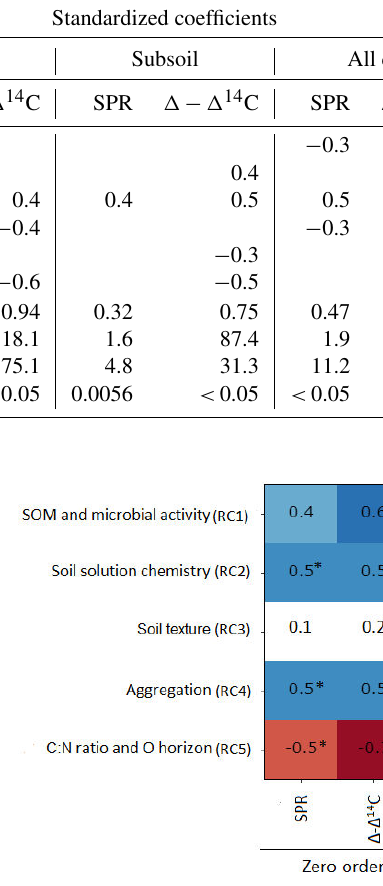
Table 3. Results of three regression models (topsoil only, subsoil only and all data) using RC scores to predict SPR and (cid:49) − (cid:49) 14 C, including standardized coefficients and model performance indicators. For models using all data, soil depth was included as an additional explanatory variable. Blank cells indicate non-significant predictors ( p value < 0.1) that were not selected by the model. Note: SOM is soil organic matter.